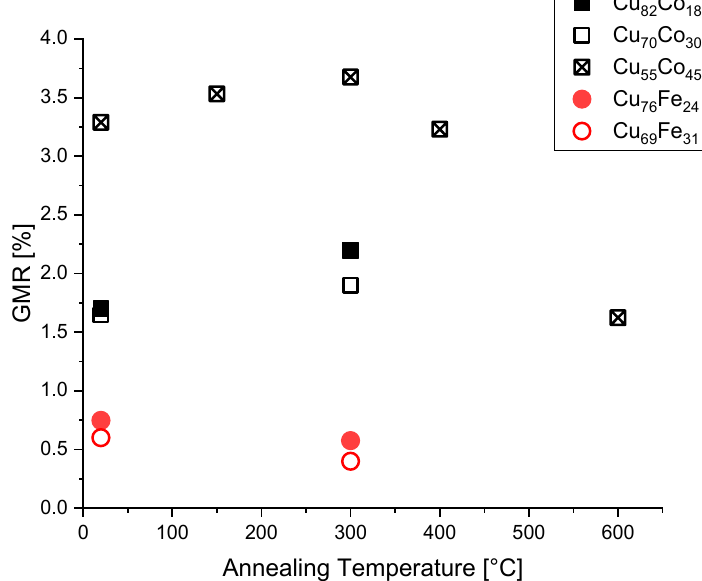
Figure 10. Absolute value of GMR for all investigated Cu–Co and Cu–Fe materials and for different annealing temperatures. Values are measured in magnetic fields of 22.5 kOe. While Cu 55 Co 45 shows highest GMR for annealing at 300 °C and all other Co-materials also increase in GMR, this is not the case for Cu–Fe, where a smaller GMR was found after annealing at 300 °C.